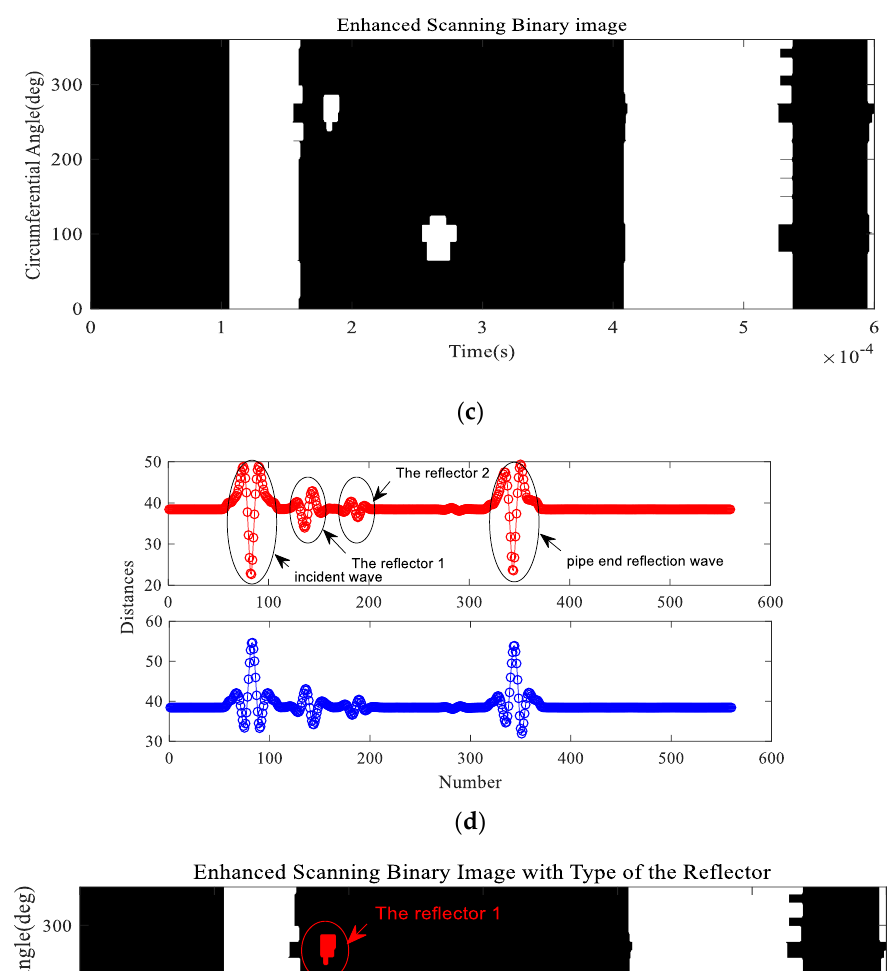
Figure 15. Analysis results based on the proposed method: ( a ) a sample pipe with two reflectors; ( b ) original 2D scanned image ( Up ), enhanced 2D scanned image ( Middle ) and smoothed 2D scanned image ( Down ); ( c ) enhanced 2D scanned binary image; ( d ) distance curves Ψ 1 ( Up ) and Ψ 2 ( Down ); ( e ) updated judgment results to the enhanced 2D scanned binary image with different colours.